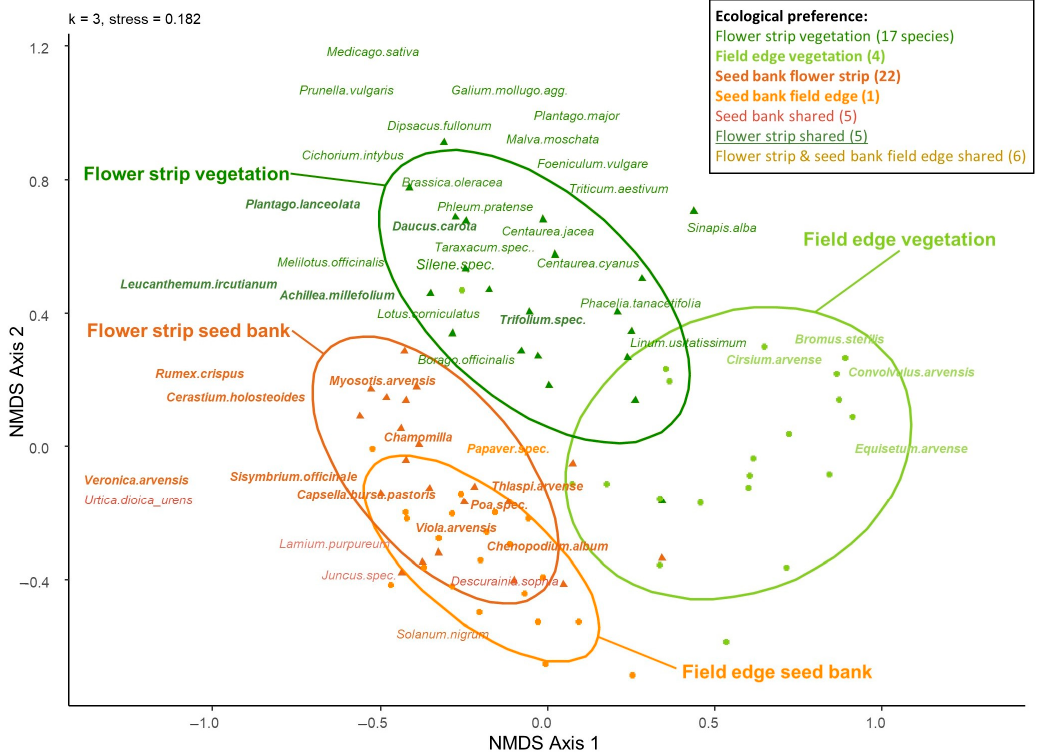
Figure 7. NMDS with Jaccard distances based on species presence/absence data including 96 spe- cies/complexes (rare species excluded) (k = 3, stress = 0.182). Circles show 85% con fi dence interval for species composition of seed bank and vegetation on fi eld edges and fl ower strips. Only species with a signi fi cant ecological preference for fi eld locations are shown (see box top right, statistic re- sults in Table S5).